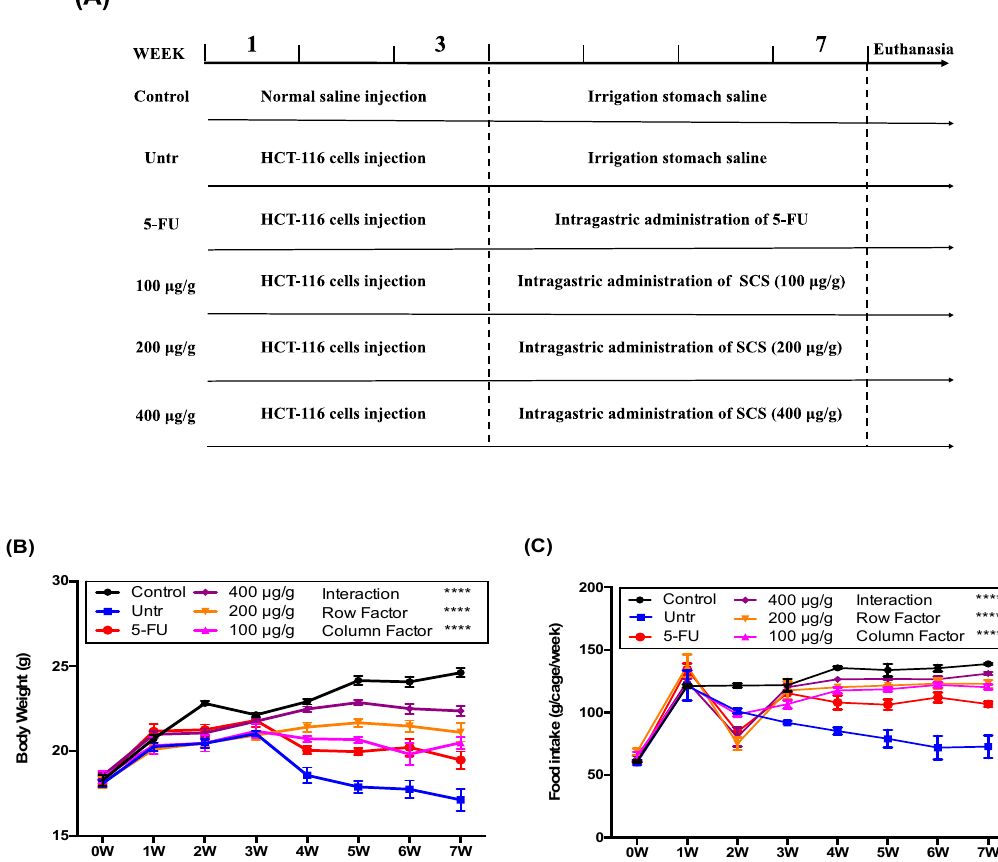
Figure 4. Effect of SCS on body weight and food intake in HCT-116 xenograft tumor mice model. Colon cancer HCT-116 cells were injected into BALB/c nude mice to develop the CRC model, while the control group was injected with normal saline. After 3 weeks, mice received an intragastric administration of different doses (100, 200, and 400 μ g/g/day) of SCS (spine) and 5-FU (100 μ g/g/day) as a positive control for 4 weeks. ( A ) Diagram of the experimental design, ( B ) body weight, ( C ) food intake. All results are expressed as mean ± SEM ( n = 10). **** indicates p < 0.0001 as compared to every other group.